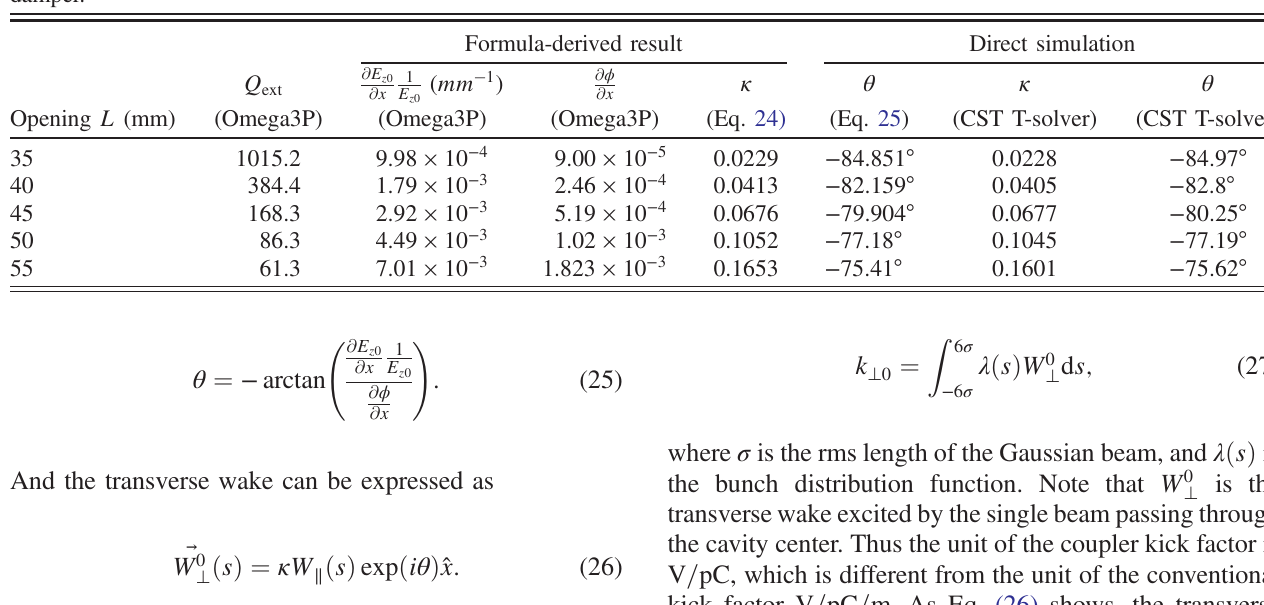
TABLE I. The κ and θ from time-domain and frequency-domain calculations with different coupling strengths through the on-cell damper.